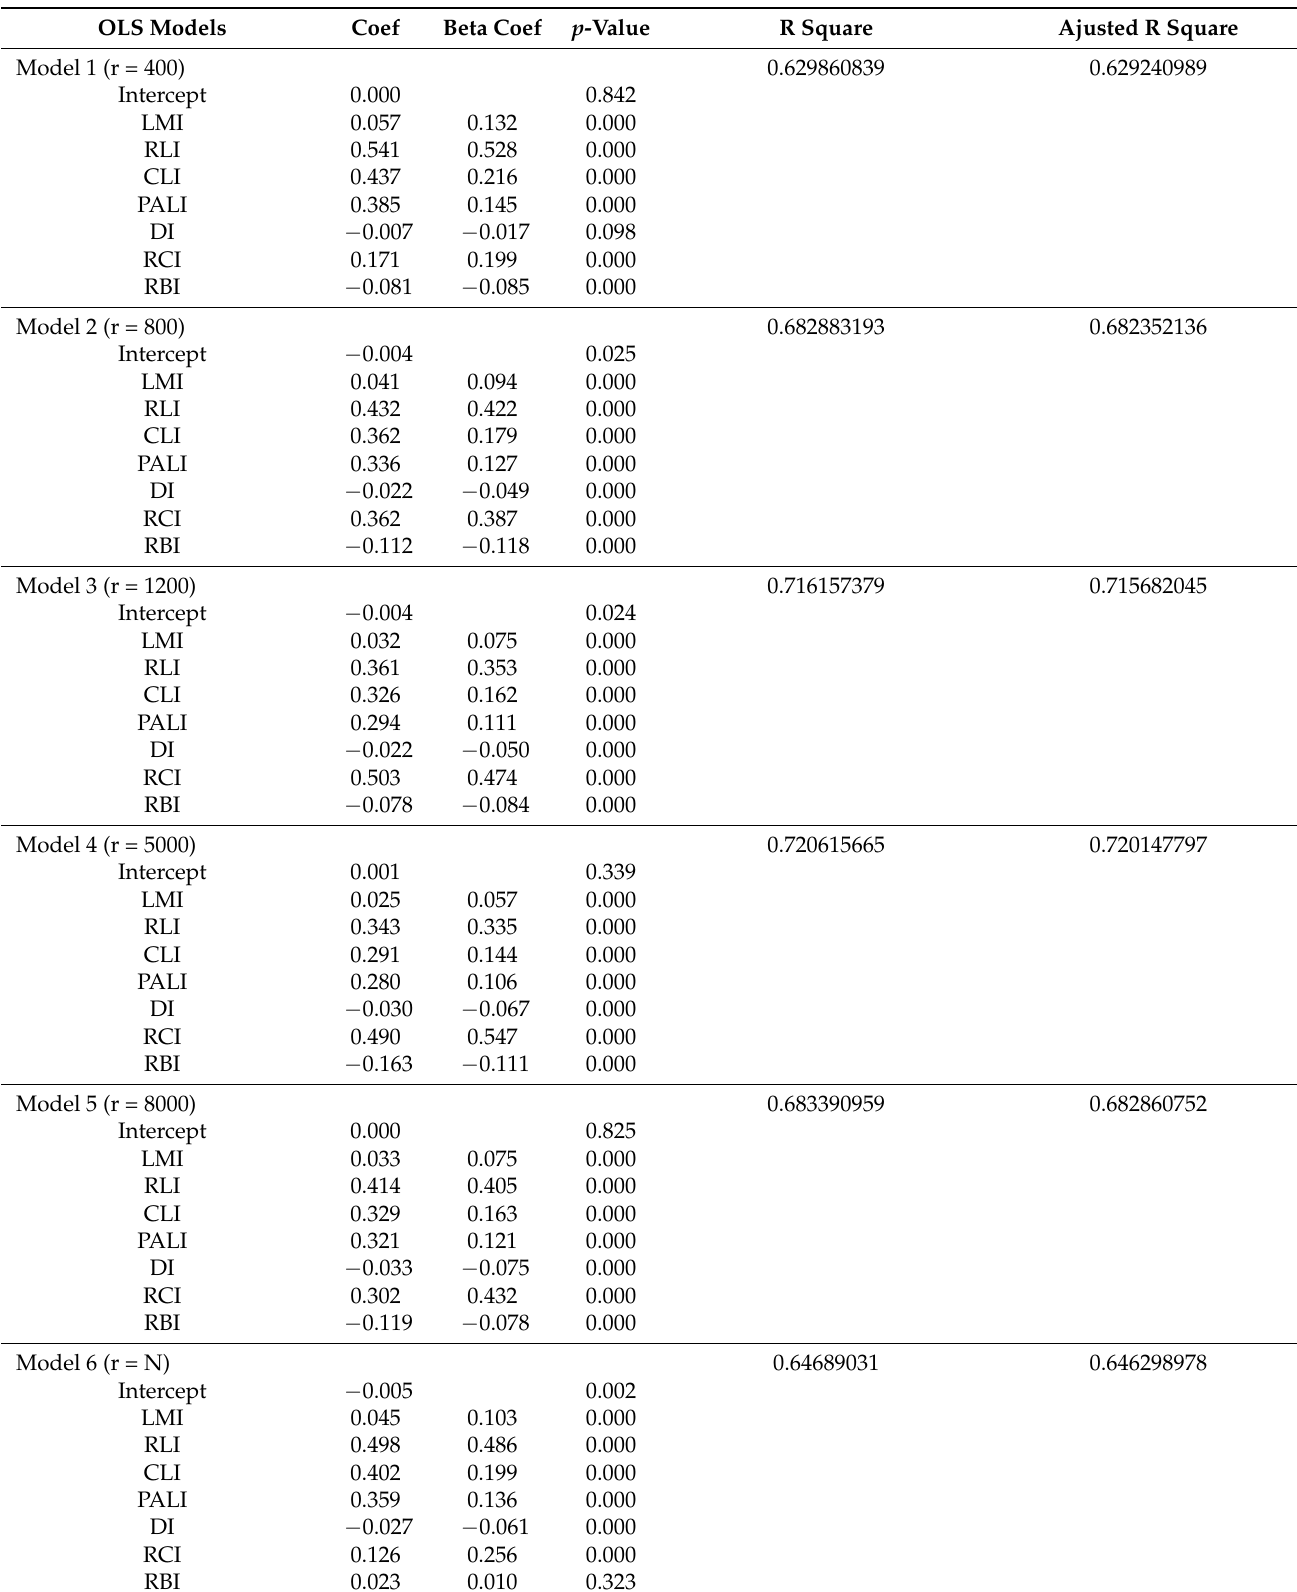
Table A3. The resulting for ols model between USV and built environment variables under different search